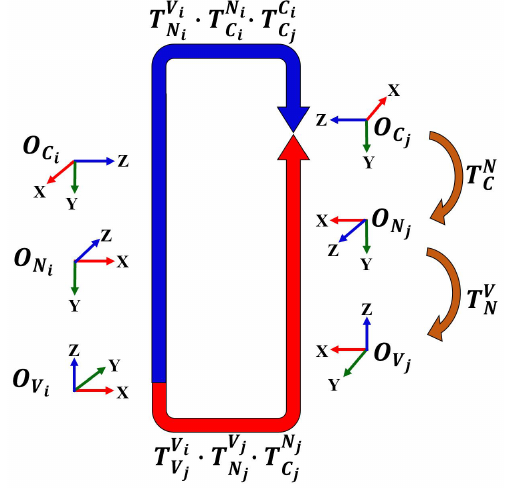
Figure 3. Closed-loop transformation between any frame i and j